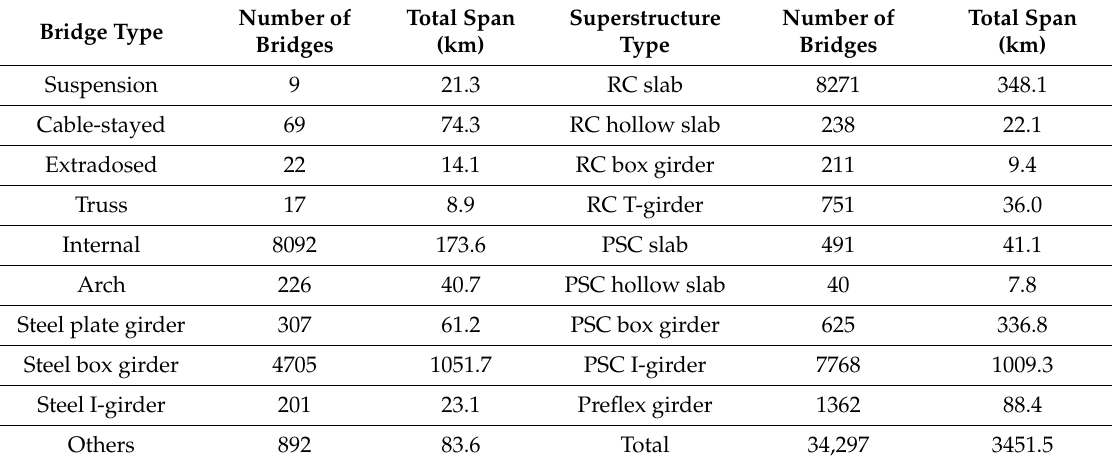
Table 1. Distribution of bridges by superstructure type in